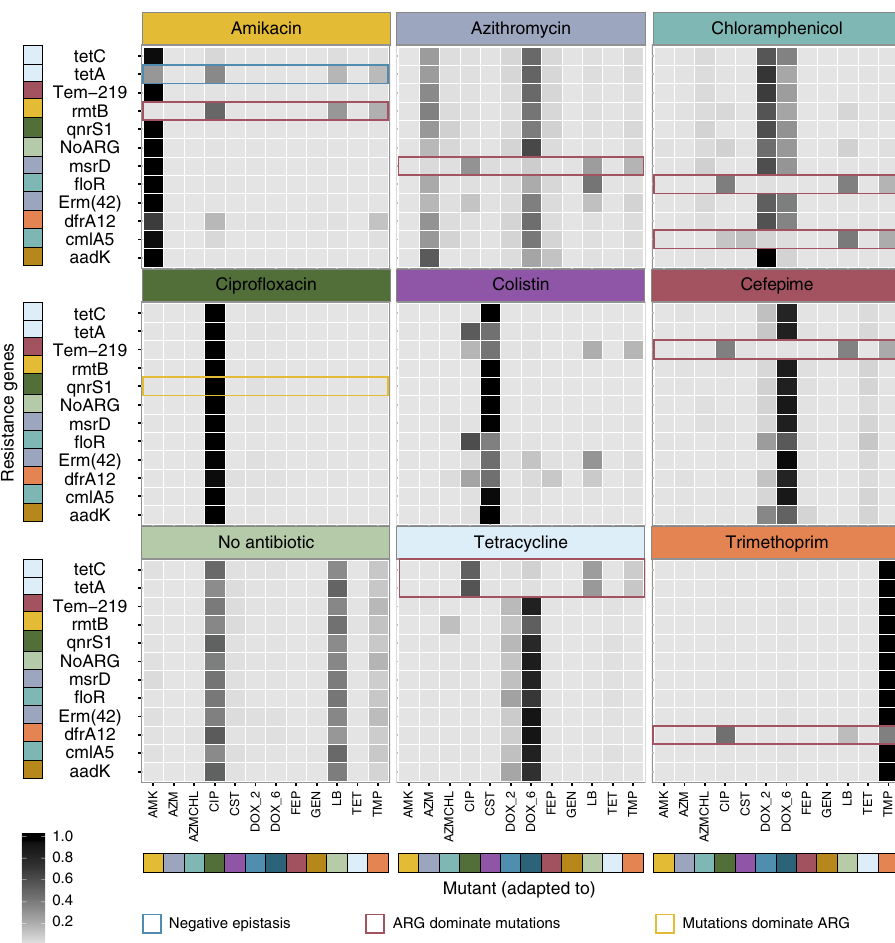
Fig. 2 Selective patterns of mutant pools transformed with antibiotic resistance genes. Each ARG-mutant pool was subjected to different drugs (indicated above the panels) at a concentration twice that of the WT MIC. The shading of the heatmap tiles illustrates the relative abundance of each mutant within each ARG-associated mutant pool. Highlighted combinations (except yellow) show the signi fi cant deviations (ANOVA, p < 0.05) from the null-hypothesis that the ARG has no in fl uence on the mutant distribution across at least two replicates. Combinations highlighted in red illustrate the cases where the ARG shields mutants that would otherwise be selected. Blue highlights situations in which an ARG that does not confer resistance to the antibiotic tested reduces the selection of the mutant; suggesting a negative interaction between the mutant and the ARG. Cases highlighted in yellow demonstrate the selection of the resistant mutant despite the presence of a resistance gene conferring resistance to the antibiotic tested, suggesting a dominant effect of the mutant over the resistance gene. ARG and mutant labels are colored according to the expected main resistance conferred. AMK (amikacin), AZM (azithromycin), AZMCHL (azithromycin and chloramphenicol), CIP (cipro fl oxacin), CST (colistin), DOX_2 (doxycycline — low resistance), DOX_6 (doxycycline — high resistance), FEP (cefepime), GEN (gentamycin), LB (Medium without antibiotics), TET (tetracycline), and TMP (trimethoprim). Source data are provided as a Source Data fi